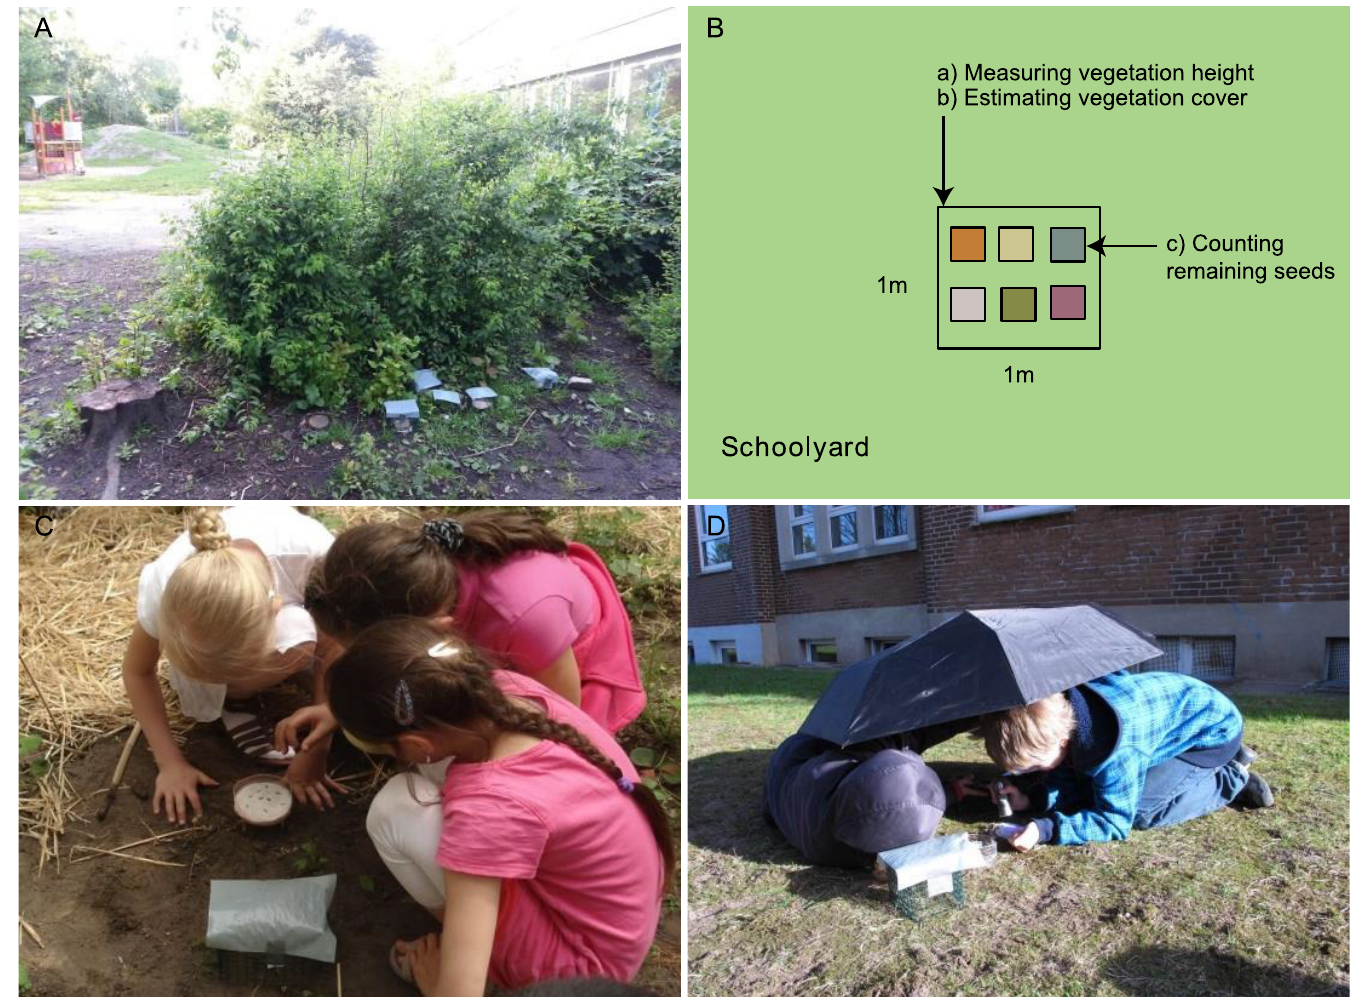
Fig 1. Illustration of the data collection on schoolyards. (A) Experimental set-up at a typical school yard, (B) schematic overview of the experiment with the different tasks children had to carry out, (C) children counting seeds in the treatment and (D) seed counting with UV-flashlights and